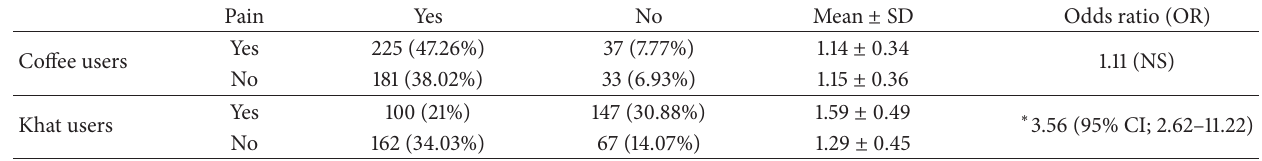
Table 4: Self-reported pain and its association with the use of coffee and